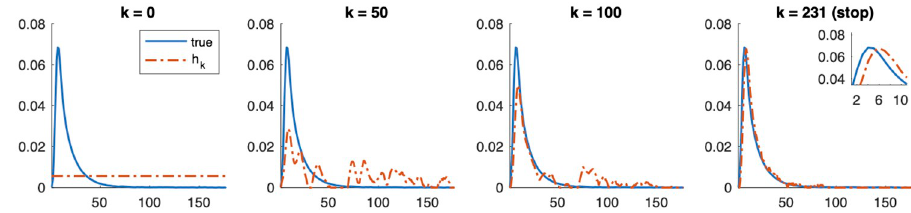
Fig 8. Reconstructed impulse response functions ~ h for the nonlinear respirometry problem at various iterations of the alternating optimization method. The subfigure in the right plot is a zoom of the peak of the reconstruction.